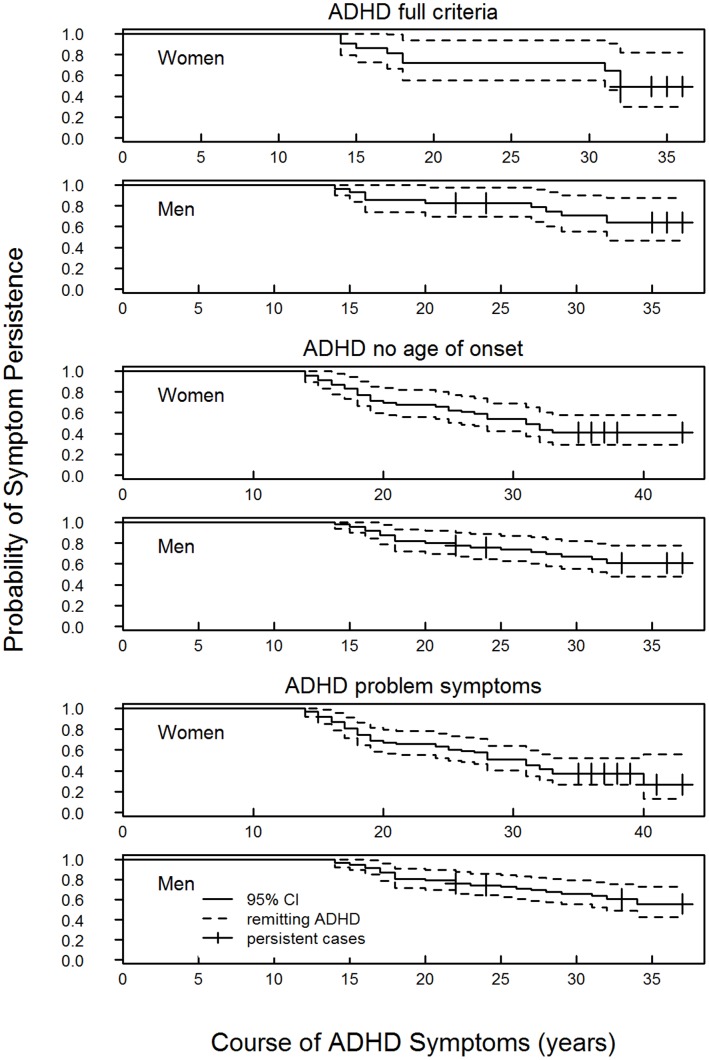
Probability of ADHD persistence and pattern of remission for each ADHD categorisation by gender.